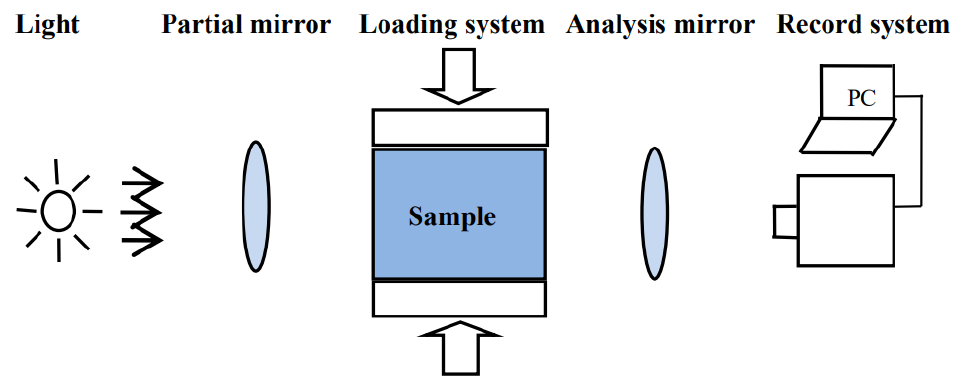
Figure 4. Arrangement of stress birefringence effect test.